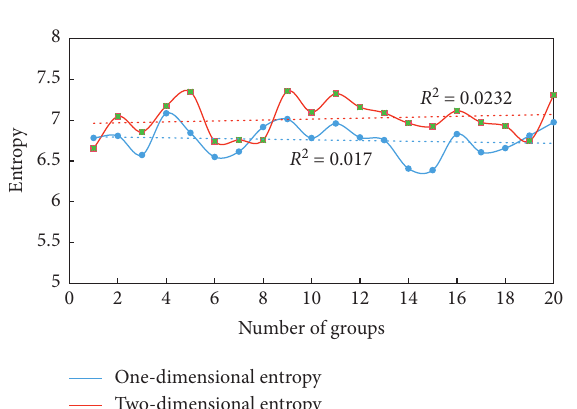
Figure 11: Average and median entropy of sand image with different